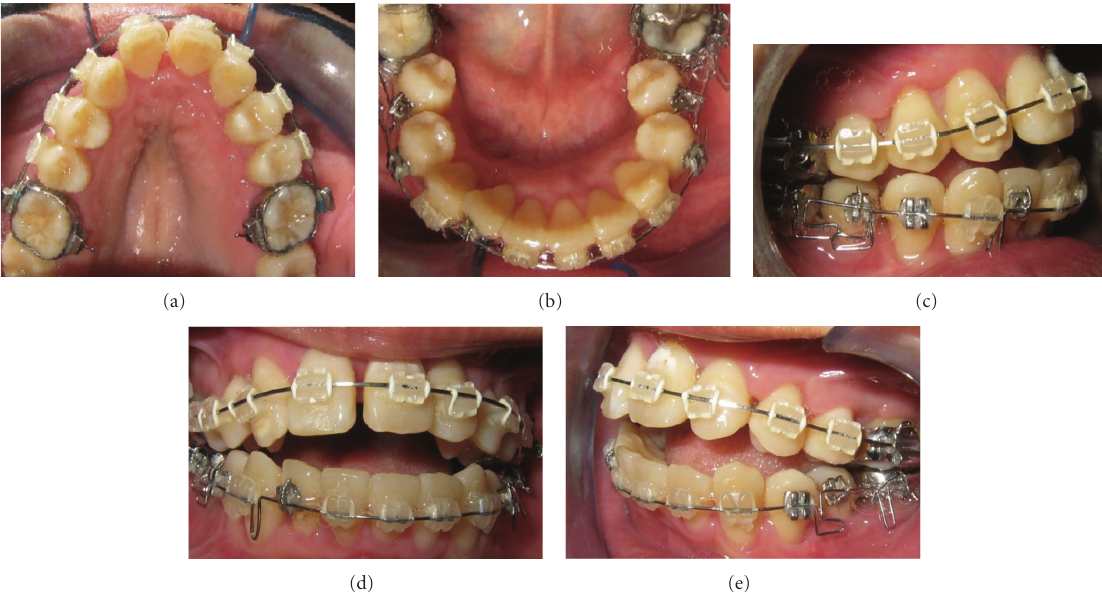
Figure 7: Intraoral photographs 10 weeks after corticotomy.